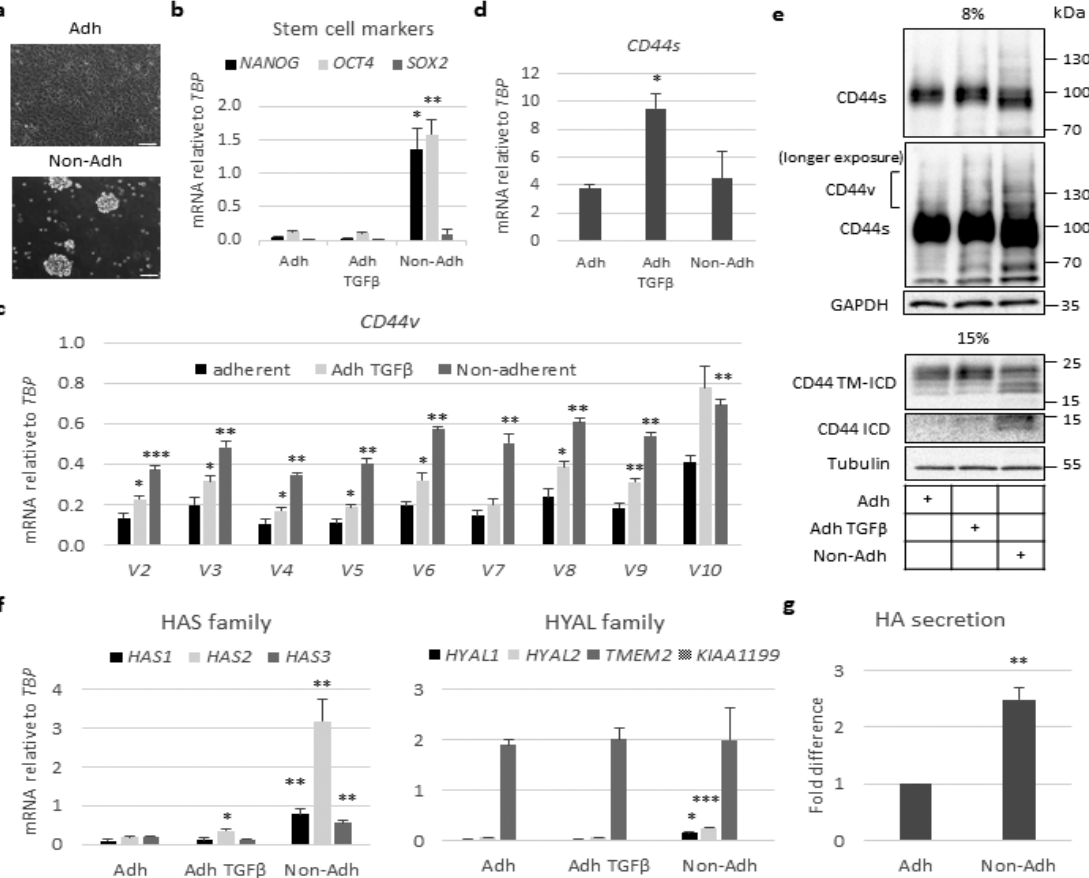
Figure 2. CD44 cleavage increases in stem-like A549 cells grown in spheres. ( a ) Phase contrast microscopy of A549 grown in adherent (Adh) or low-attachment conditions (Non-adh) for 96 h. Zeiss Axiovision was employed to take the micrographs (bars = 100 μ m). ( b – d ) A549 cells were cultured under adherent conditions or as spheres. Adherent cells were stimulated or not with TGF β for 24 h. The mRNA levels of transcription factors NANOG, OCT4, and SOX2 ( b ), as well as CD44v isoforms ( c ) and CD44s ( d ) were determined by real-time qPCR and normalized to TBP mRNA levels. ( e ) Lysates from adherent A549 cells, stimulated or not with TGF β for 24 h, and non-adherent A549 cells were subjected to SDS-PAGE using 8% and 15% polyacrylamide gels, followed by immunoblotting for CD44s and CD44v, CD44 TM-ICD, and CD44 ICD; GAPDH and tubulin were used as loading controls. ( f ) The mRNA levels of hyaluronan synthase ( HAS1 , HAS2 , HAS3 ) and hyaluronidase ( HYAL1, HYAL2, TMEM2, KIAA1199 ) family members were determined by real-time qPCR and normalized to TBP . ( g ), Hyaluronan levels in the culture medium of adherent and non-adherent A549 cells were evaluated by an enzyme-linked immunosorbent assay (ELISA)-like assay and normalized against protein amounts; values are expressed as fold difference. Asterisks illustrate significant differences between the different conditions compared to the respective adherent ones: * p < 0.05, ** p < 0.01, *** p < 0.001.